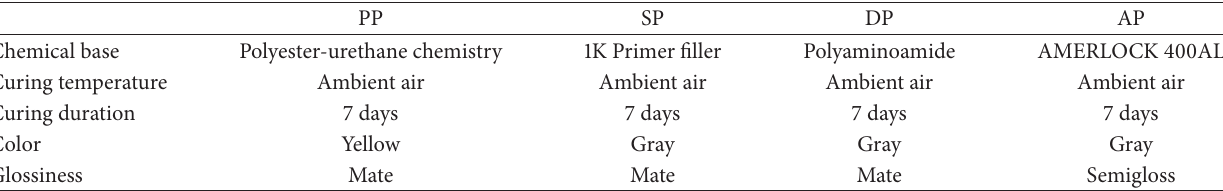
Table 3: Characteristics of different primers.